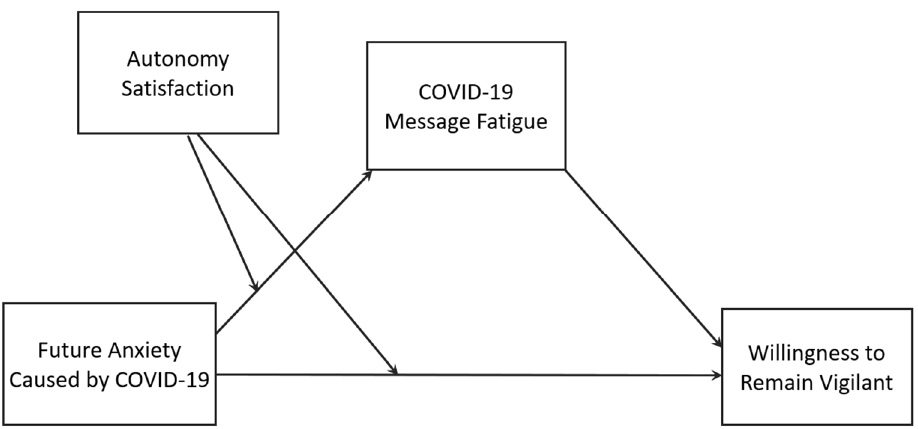
Figure 2. Illustration of the proposed moderated mediation model.